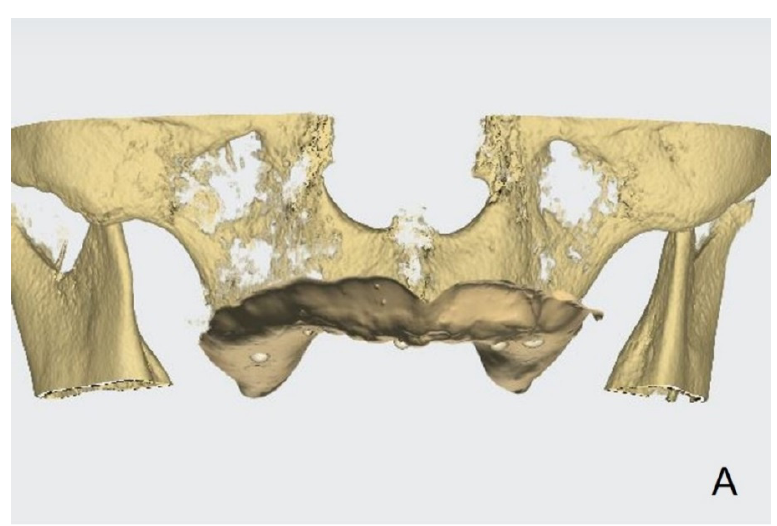
Figure 2. Scan the impression surface of the patient’s prostheses. The upper and lower occlusal re- lationships were scanned.